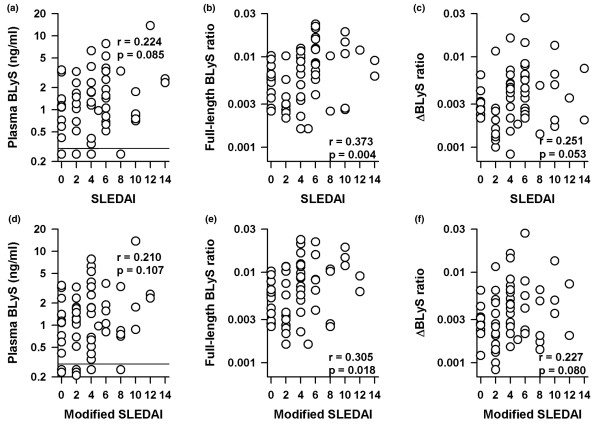
Correlations in the SLE patients between BLyS parameters and disease activity. Individual (a,d) BLyS protein levels, (b,e) full-length BLyS mRNA levels, and (c,f) ΔBLyS mRNA levels are plotted against corresponding SLEDAI scores (a–c) or modified SLEDAI scores (d–f). BLyS, B lymphocyte stimulator; SLEDAI, Systemic Lupus Erythematosus Disease Activity Index.